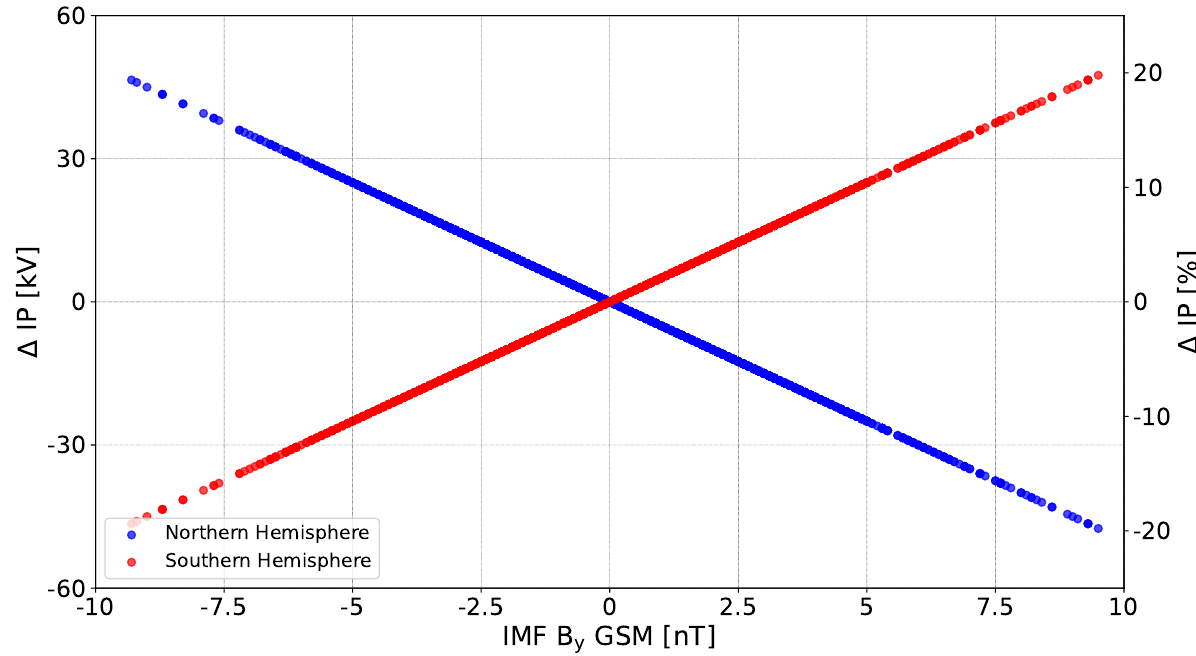
Figure 2. The estimated IMF B y -associated perturbations in ionosphere-to-ground potential for the 1999–2002 period. Percentage anomalies (left y -axis) are calculated from daily average IP (250